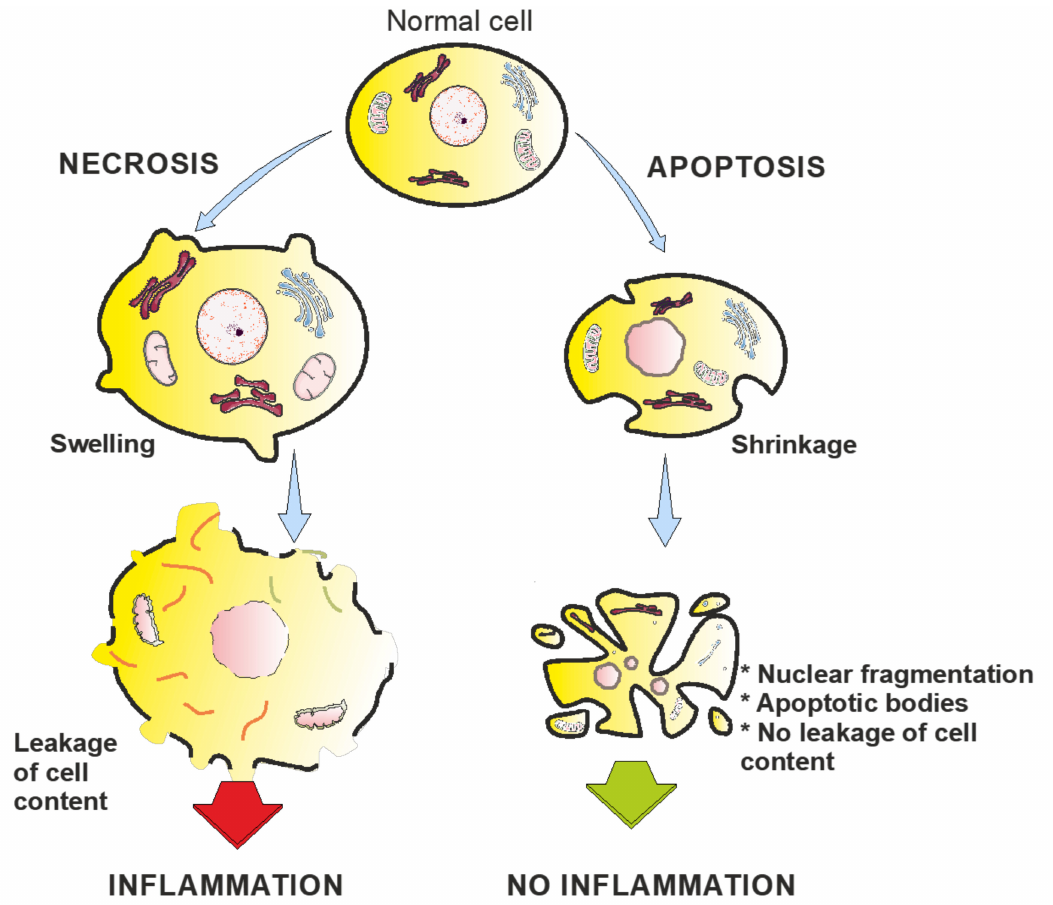
Figure 2. Simplified representation of necrosis and apoptosis in